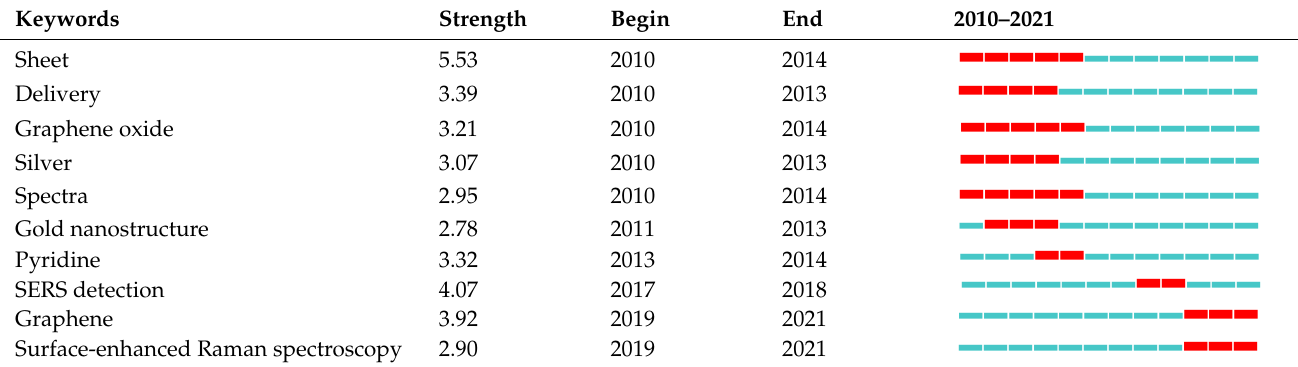
Table 5. The 10 keywords with the strongest bursts during the research history of the graphene ‐ based SERS.